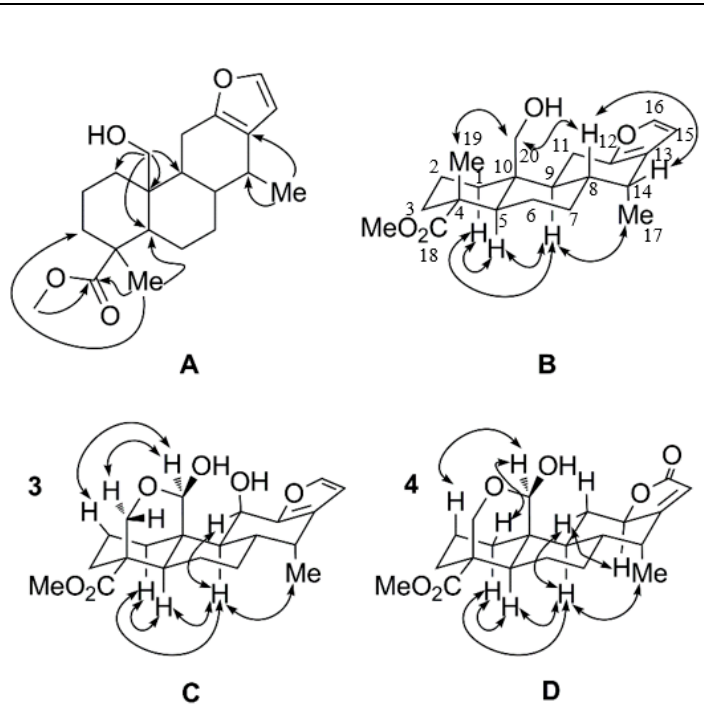
Figure 2. Key HMBC (H → C) ( A ) and ROESY correlations (H ↔ H) ( B ) for compound 1 . Key ROESY correlations (H ↔ H) for compounds 3 ( C ) and 4 ( D ).